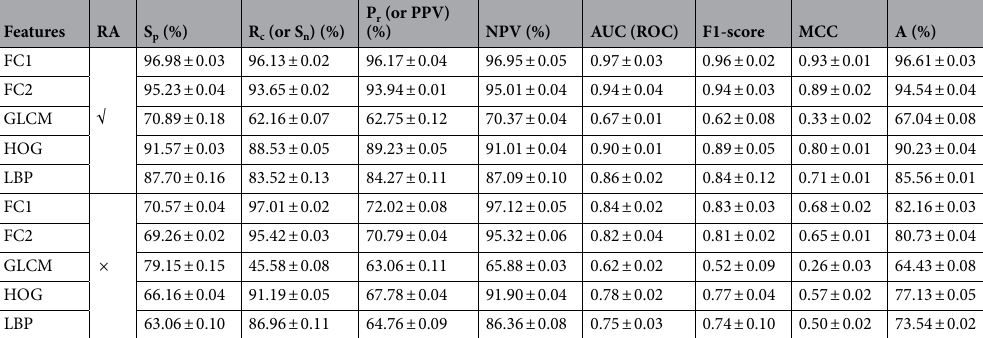
Table 13. RA effect on Radiogenomic classification results for individual feature extraction modules using a 1-NN classifier and BraTS-2021 dataset.